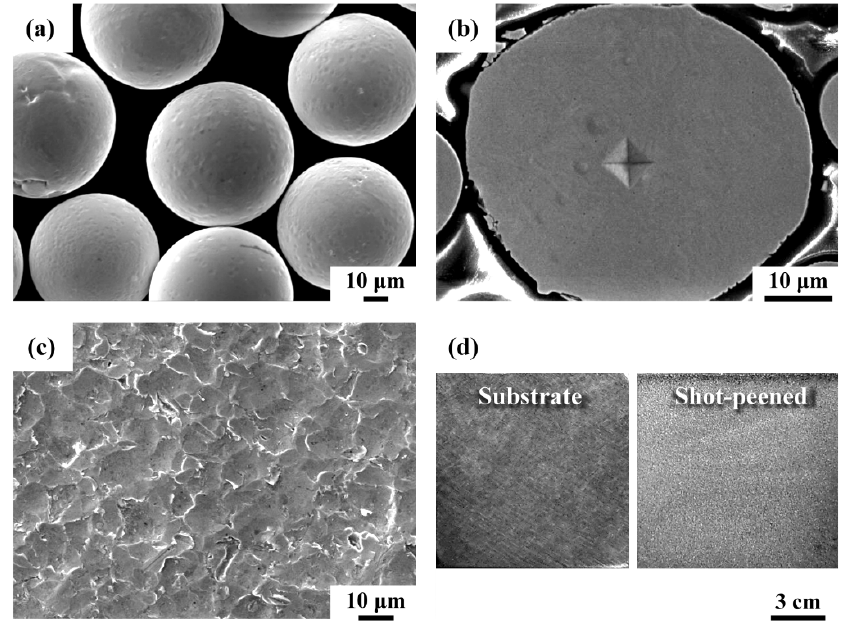
Figure 2. Surface morphology of the ( a ) amorphous shot; ( b ) the cross section of the shot with a hardness indentation; ( c ) shot-peened surface; ( d ) the macro-appearance of the substrate and the shot-peened sample.